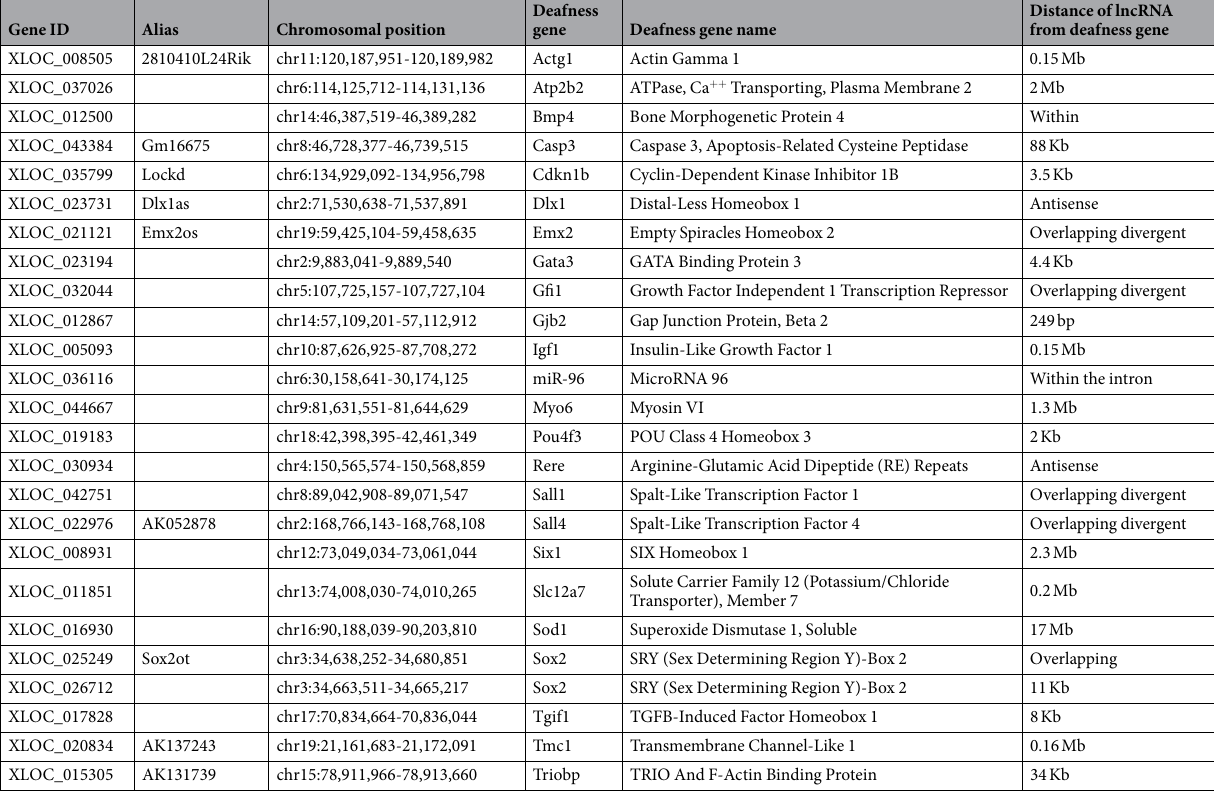
Table 2. lncRNA candidate genes that are found in proximity to MGI hearing and deafness